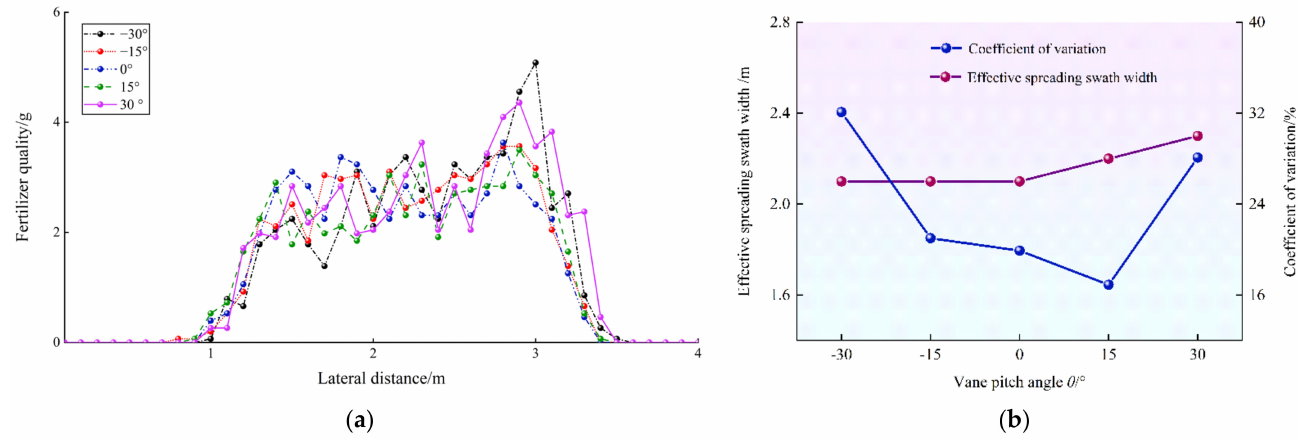
Figure 12. Effects of the vane pitch angle θ . ( a ) Fertilizer quality distribution along the lateral distance; ( b ) variations of effective swath width and C v along with θ